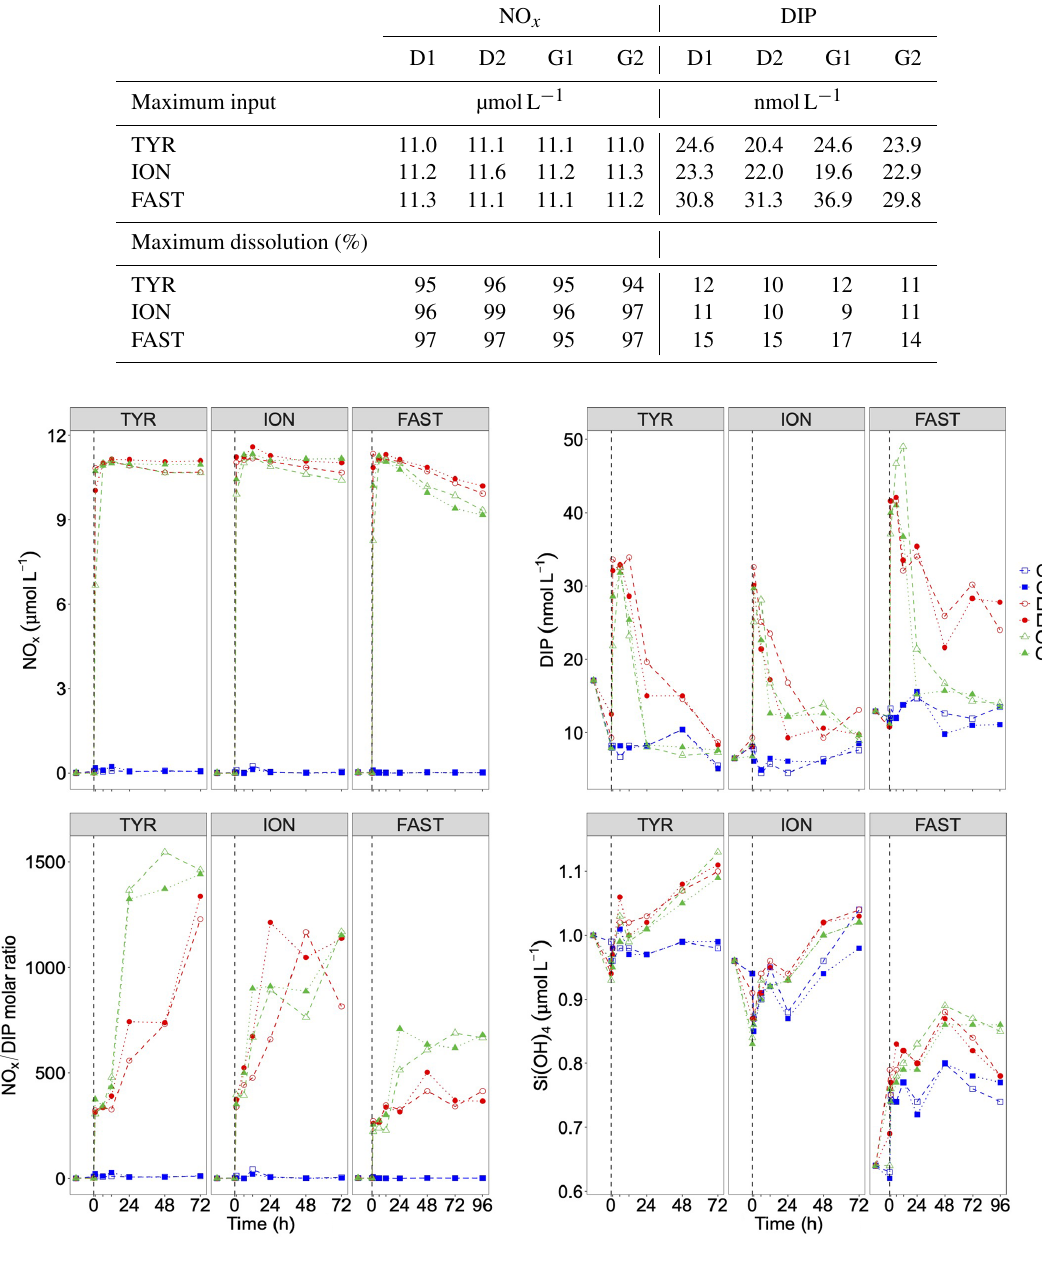
Table 3. Maximum input of nitrate + nitrite (NO x ) and dissolved inorganic phosphorus (DIP) released from Saharan dust in tanks D and G as observed from the discrete samples taken during the first 6h after seeding. The estimated maximal percentage of dissolution is also presented (see Sect. 2.3.1 for details on the calculations).